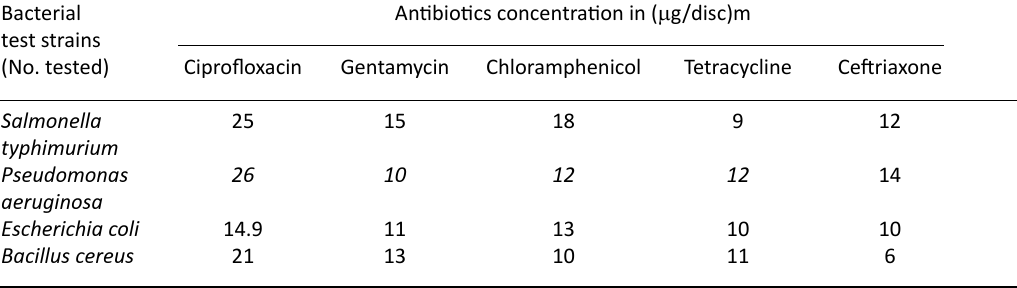
Table 3. Inhibition zoon (in mm) for different antibiotics